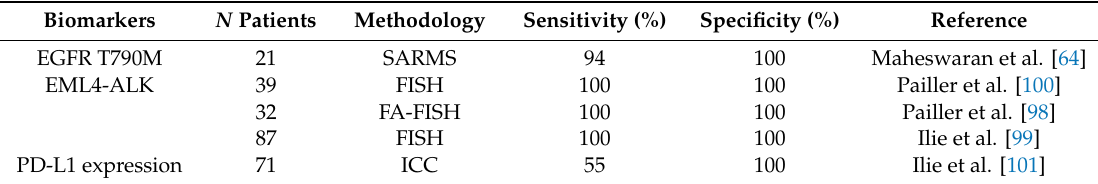
Table 2. Principal clinical biomarkers detectable by circulating tumor cells